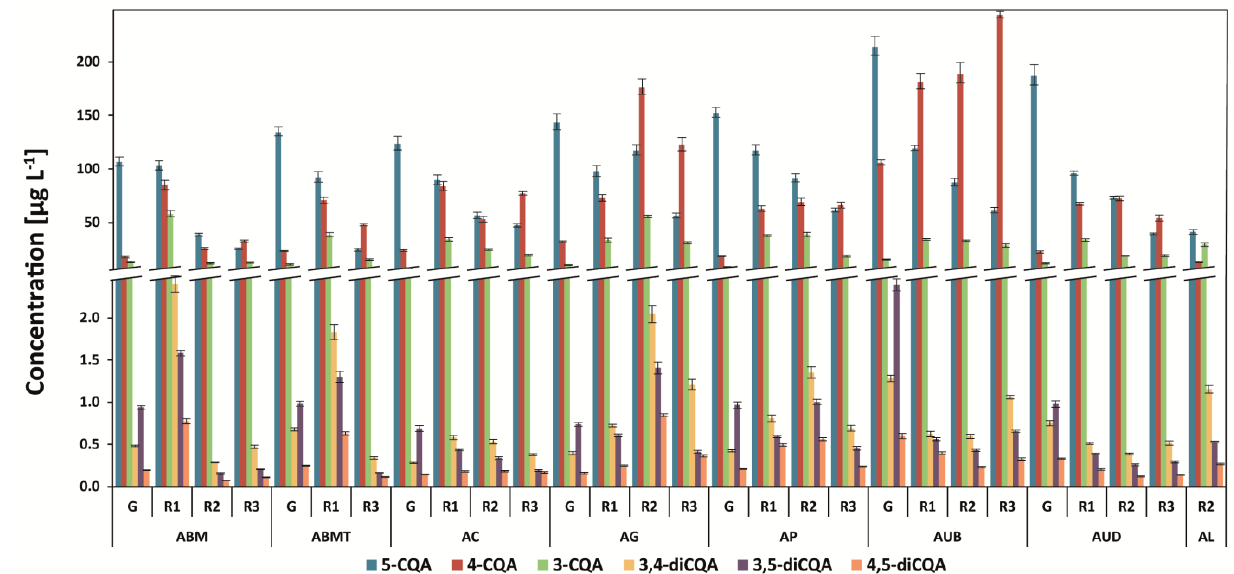
Figure 1. Chlorogenic acid (caffeoylquinic acids isomers—CQA) content in Arabica coffee brews. Leg-